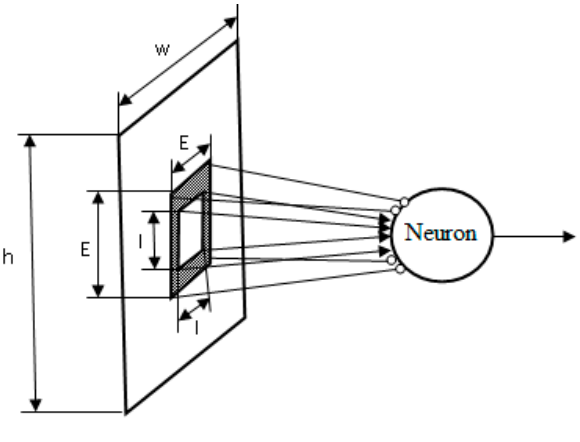
Figure 7. RLD 1 structure.